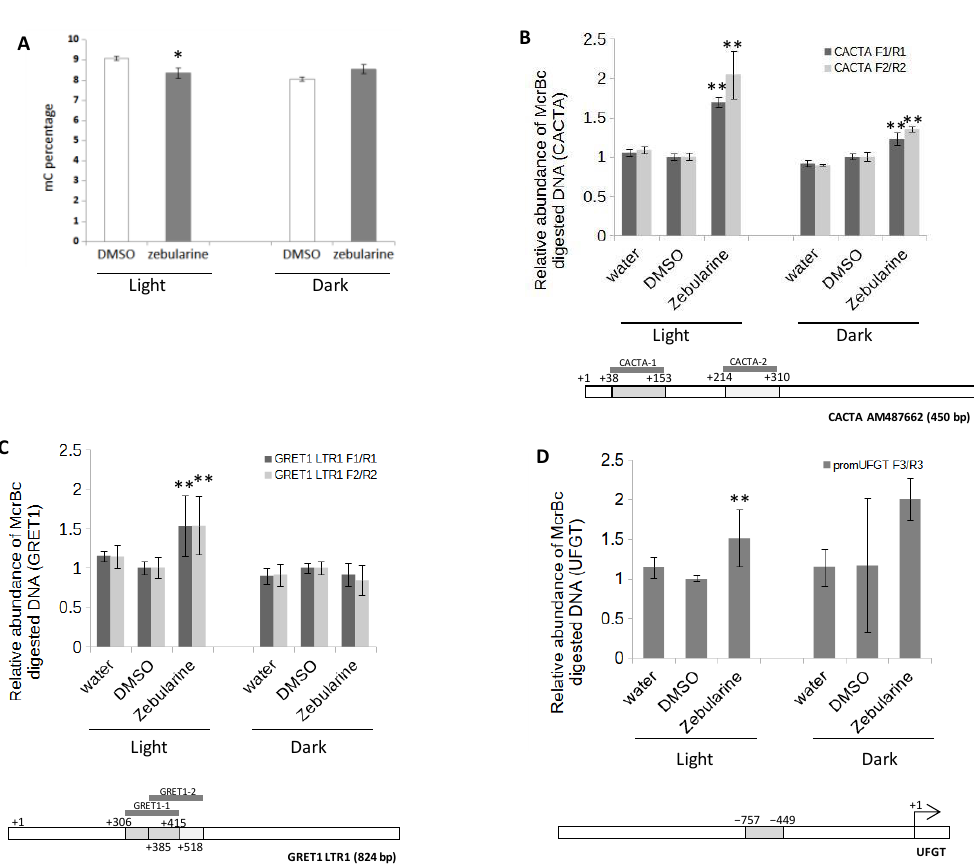
Figure 9. Zebularine hypomethylating effect is light- and locus-dependent. Global DNA methylation percentages ( A ) and locus-specific methylation levels ( B – D ) were evaluated. ( A ) Bars represent the mean value of three to five biological replicates with their standard deviations. Three